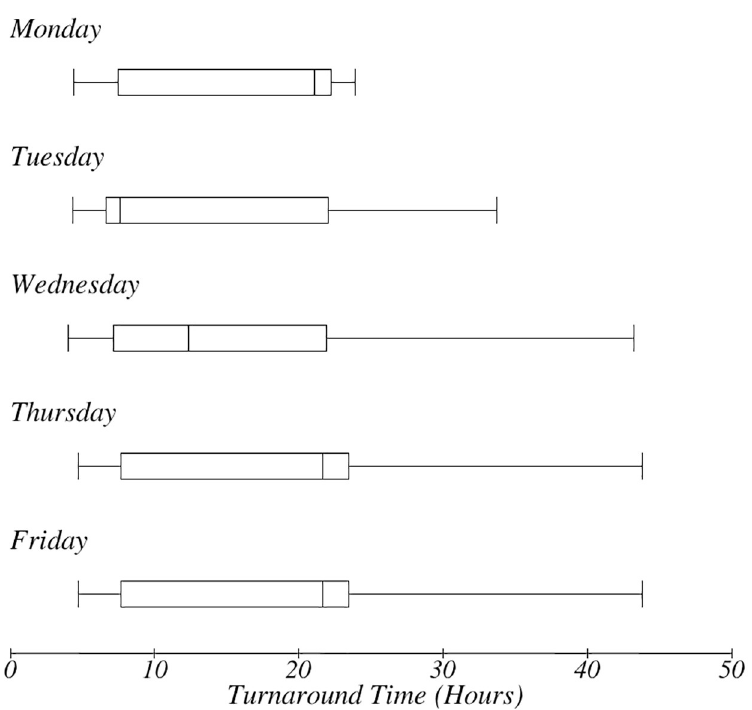
Fig 4. TAT for day of order. The box-plot shows the day of the week when the test was ordered and impact on TAT.